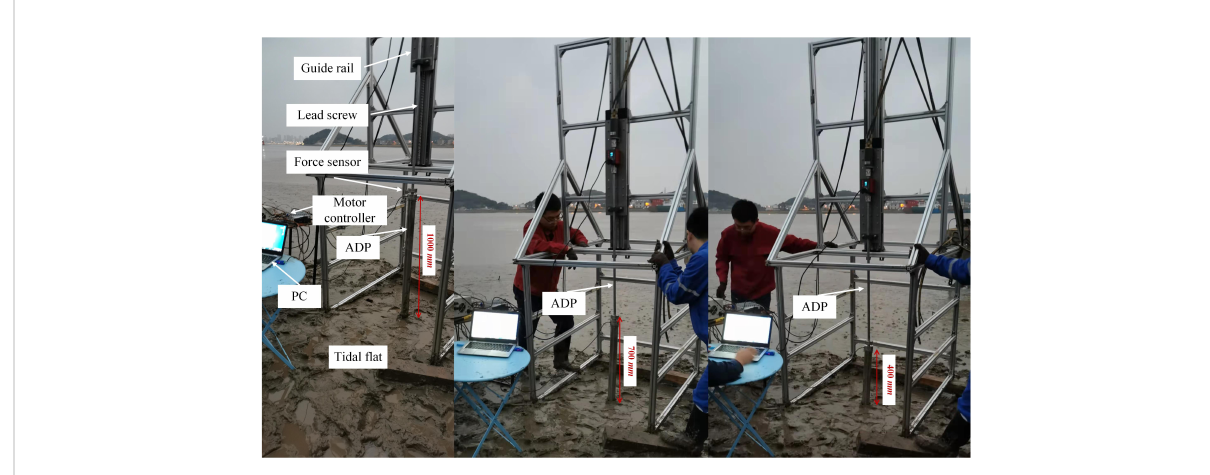
FIGURE 10 Tidal fl at penetrating experimental setup.